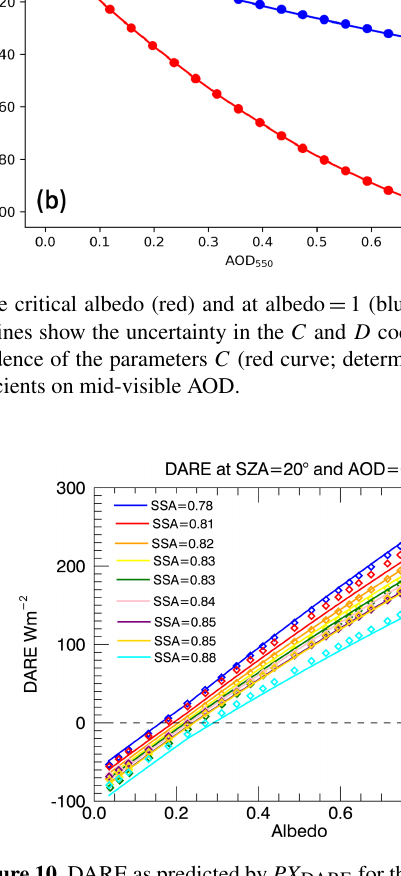
Figure 9. The difference between PX DARE and P DARE for nine case SSAs at fixed AOD (0.75) and SZA (20 ◦ ).